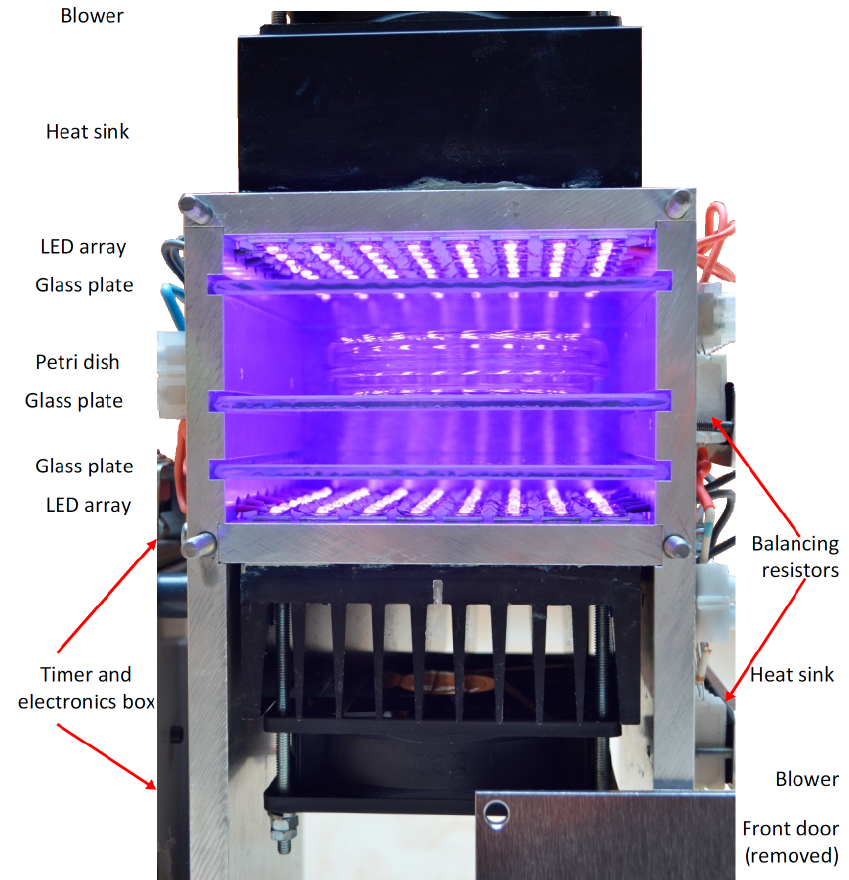
Figure 1. Setup of the high intensity 405 nm irradiation device.